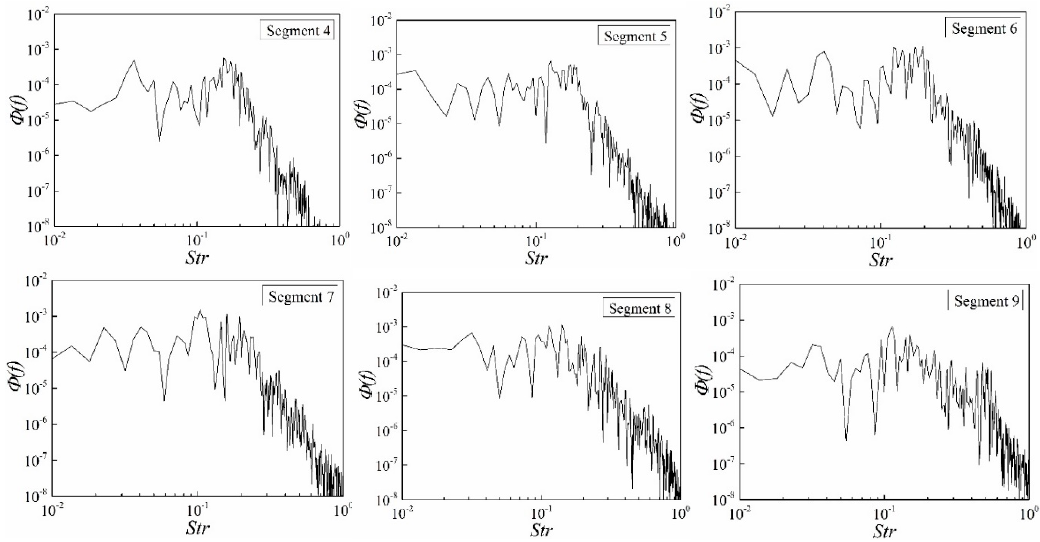
Figure 15. Power spectra of segmental lift coefficient at yaw angle of 30 ° .